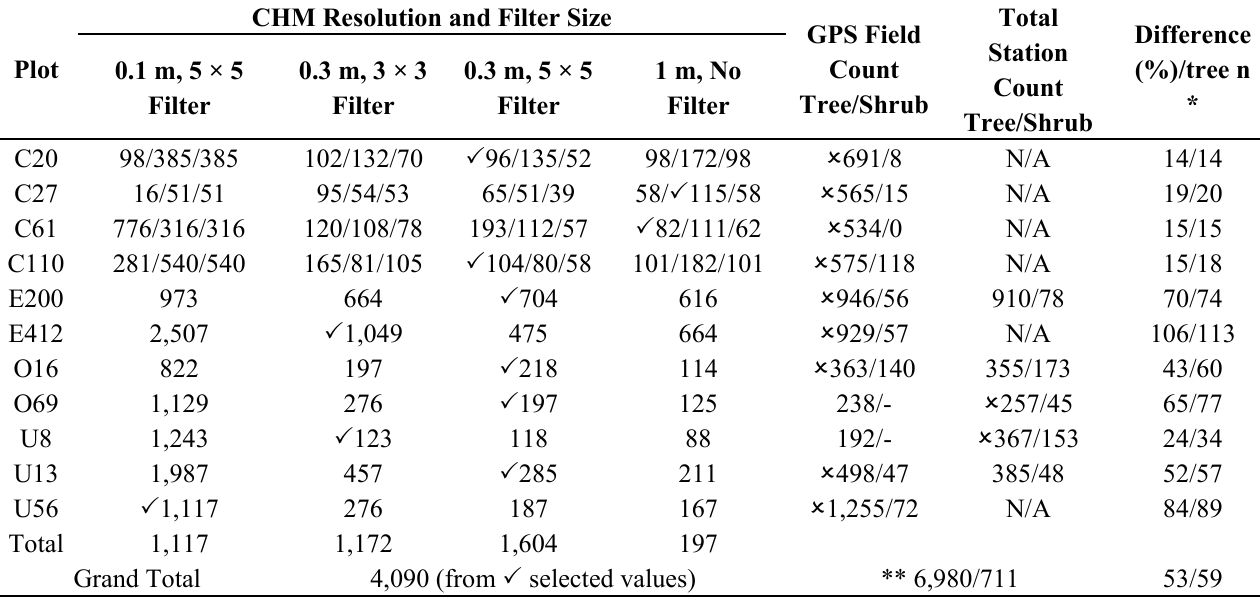
Table 6. TreeVaW LiDAR stem counts compared to GPS and total station field counts. Checked numbers indicate the resolution and filter method that best matched field measured trees based on count and spatial